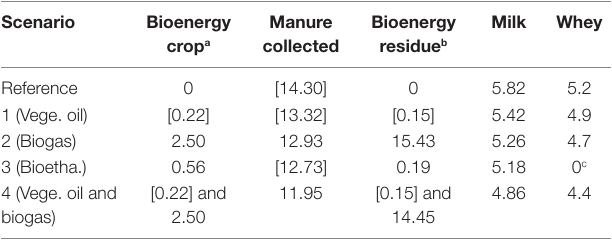
TaBle 4 | Products (other than fodder crops) that stay within each farm [in brackets] and products that are transported 5 km to or from shared facilities in each scenario.